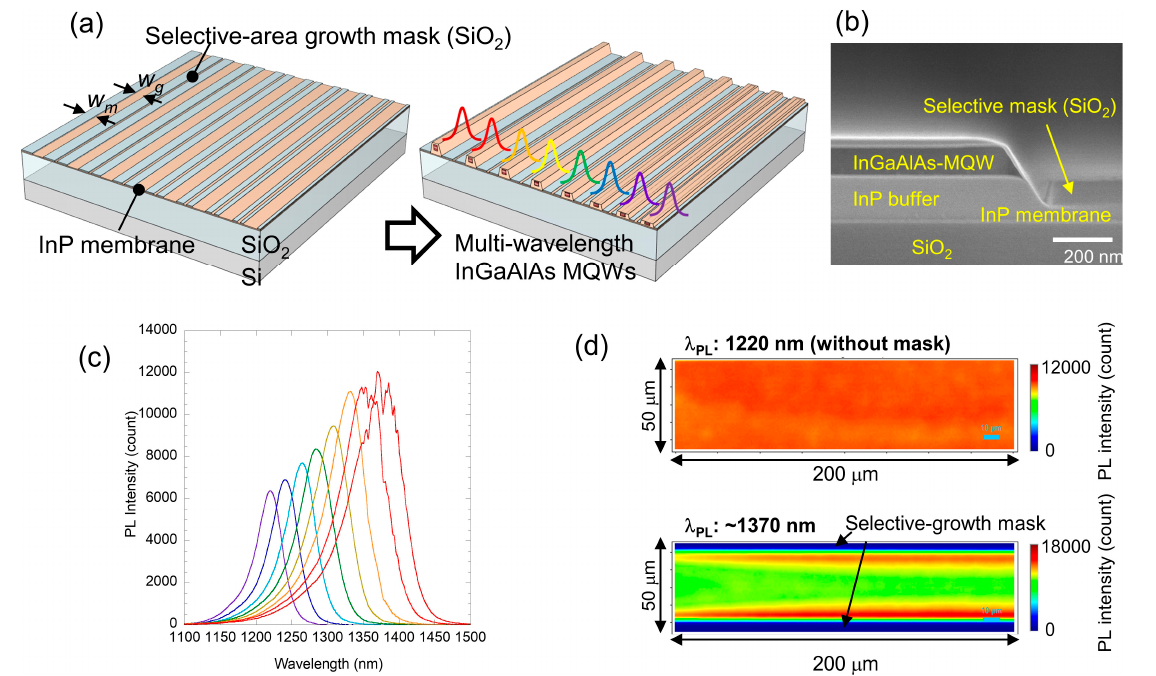
Figure 13. ( a ) Schematic of selective-area epitaxy of InGaAlAs MQWs with different bandgaps; ( b ) cross-sectional SEM image of an MQW selectively grown on InP-on-insulator substrate at the vicinity of selective growth mask; ( c ) PL spectra for selectively grown InGaAlAs-6-period MQWs on InP-on-insulator substrate; ( d ) PL-intensity distributions for MQWs without selective growth mask ( λ PL : 1220 nm) and with selective growth masks ( λ PL : ~1370 nm).